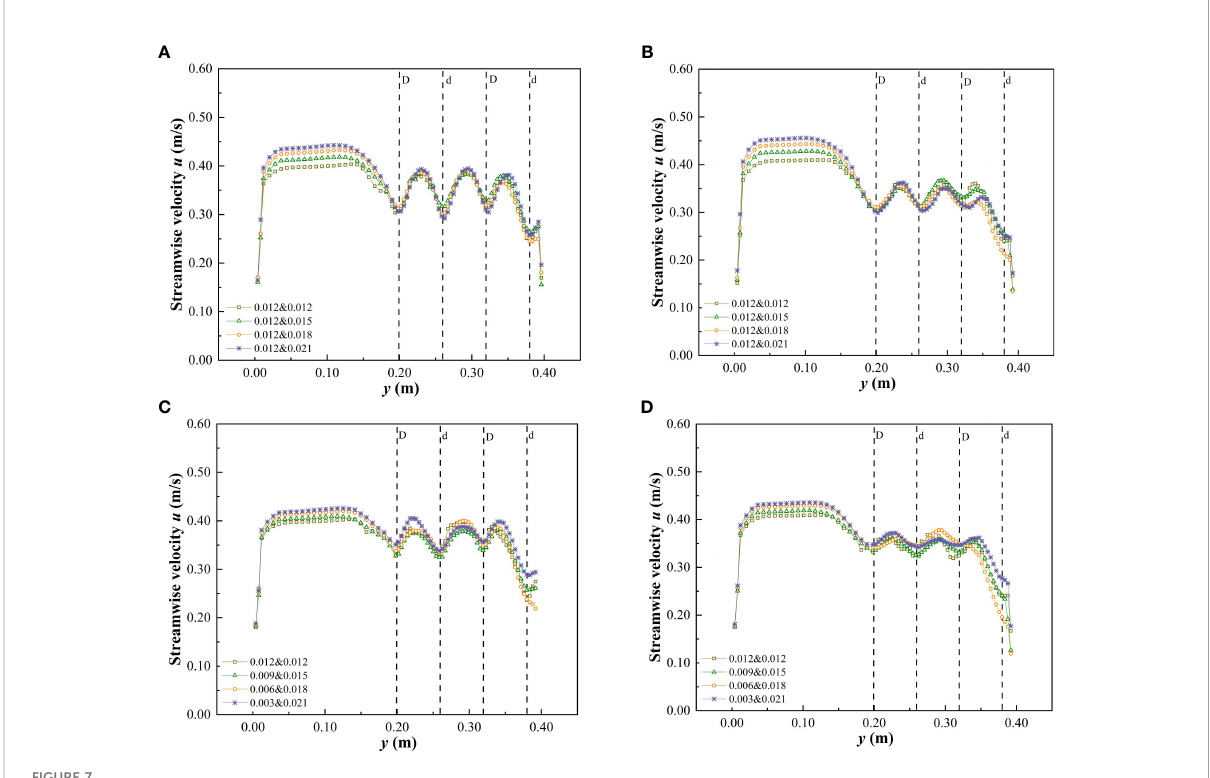
FIGURE 7 Variation of streamwise velocity in cross-section when h is 0.10 m under the submerged condition. (A) C 2 , vegetation combination distribution, (B) C 3 , vegetation combination distribution, (C) C 2 , vegetation discrete distribution, (D) C 3 , vegetation discrete distribution.